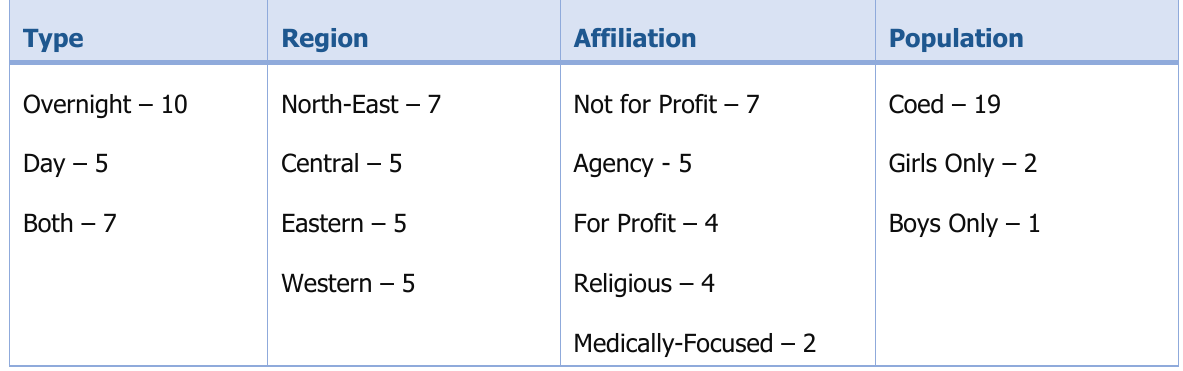
Table 2. Breakdown of Sample Stratification for the 22 ACA-Accredited Camps